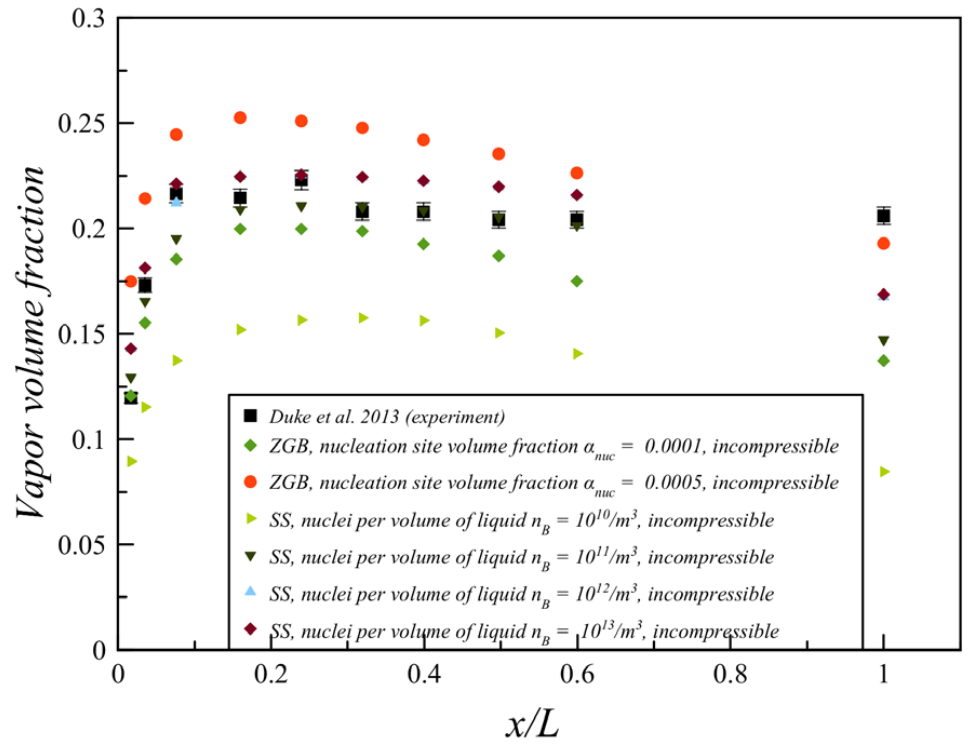
Figure 12. Influence of model constants on total vapor volume fraction at different axial positions along the nozzle.